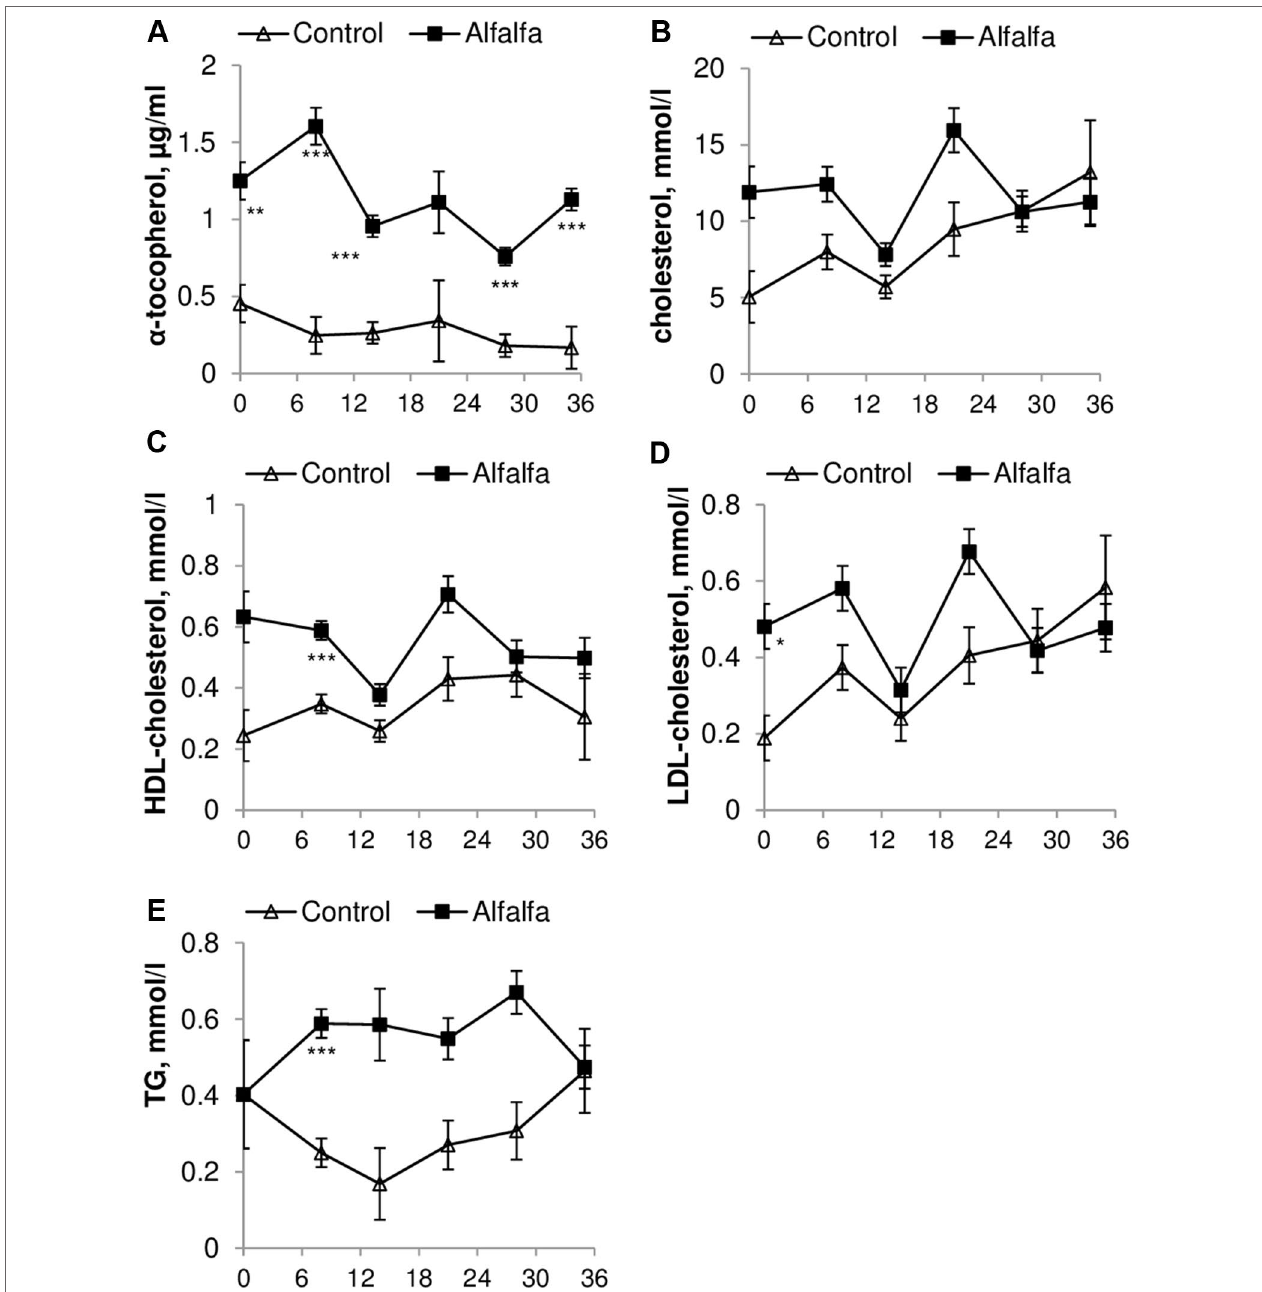
FiGURE 1 | Concentration of (A) α -tocopherol, (B) cholesterol, (C) HDL-cholesterol, (D) LDL-cholesterol and (E) TG during the entire experimental period compared with those in the CON group.